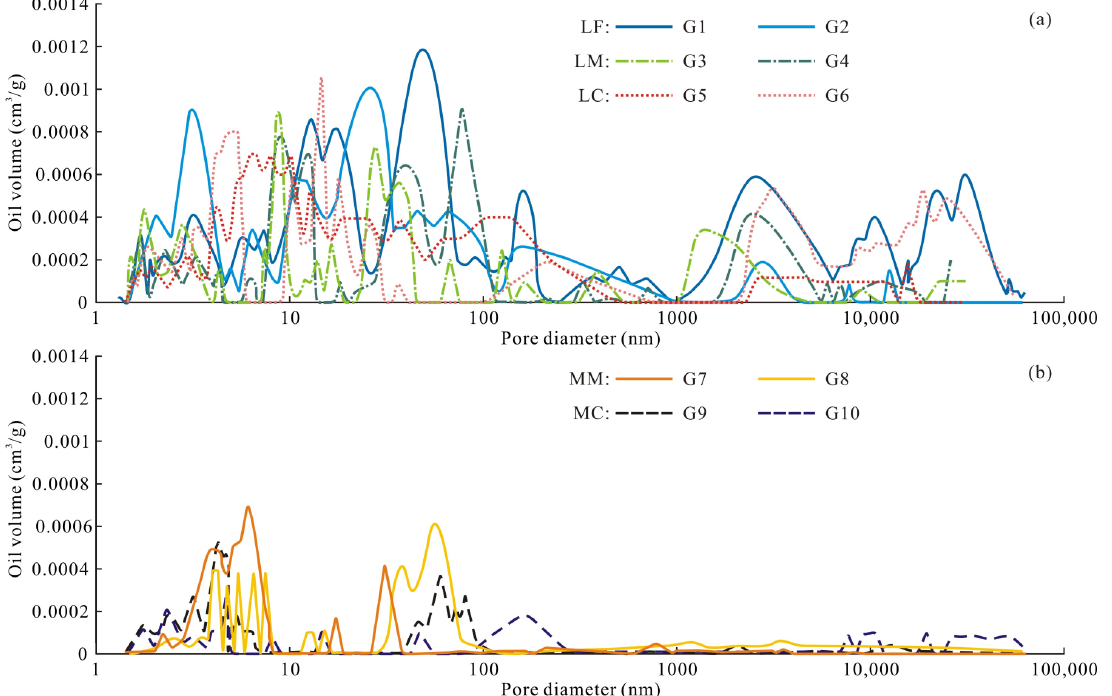
Figure 10. Pore diameter distribution characteristics of residual oil in the Ek 2 shales in the Cangdong Sag. ( a ) Oil volume distribution versus pore diameter of laminated shales. ( b ) Oil volume distribution versus pore diameter of massive shales. LF: laminated felsic shale; LM: laminated mixed shale; MM: massive mixed shale; LC: laminated carbonate shale; MC: massive carbonate shale.